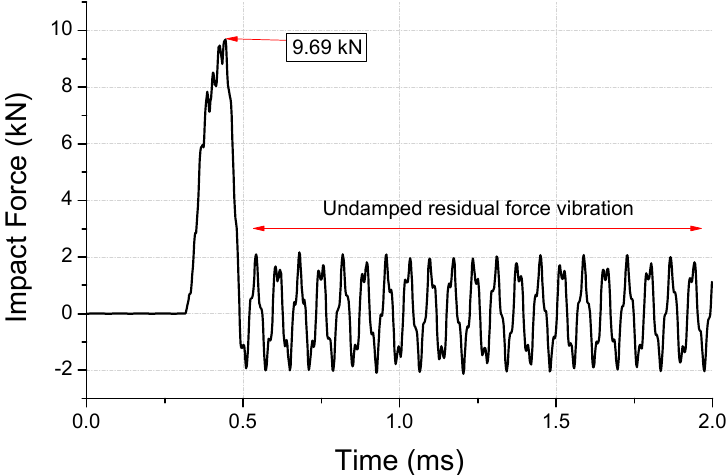
Figure 5. Analysis of the undamped impact force of first-step drop.